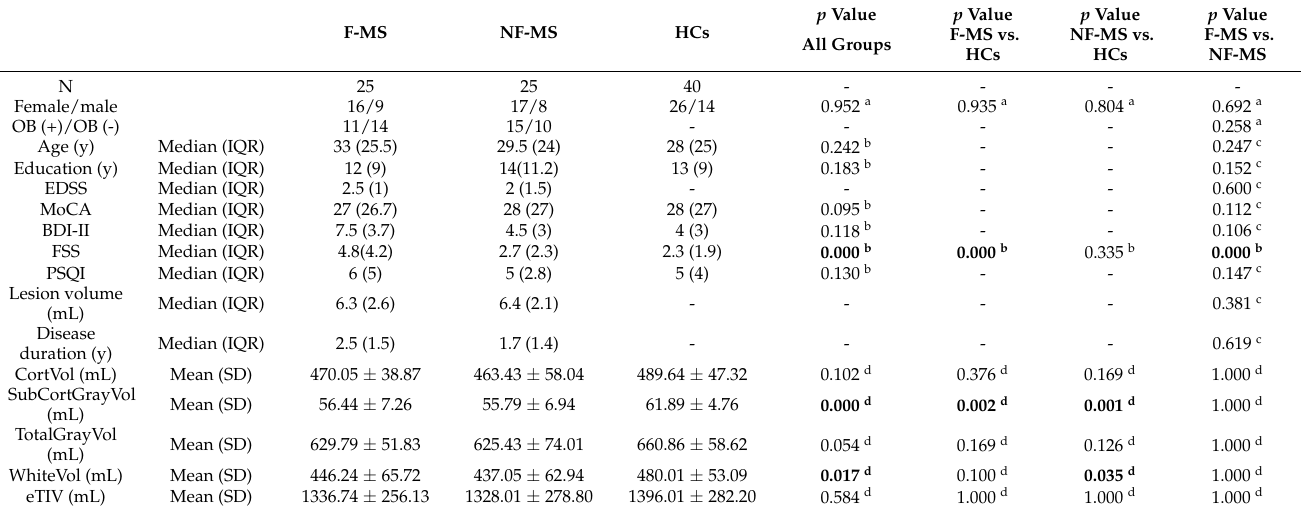
Table 1. Demographic, clinical, and cerebral imaging characteristics in the F-MS, NF-MS, and HCs